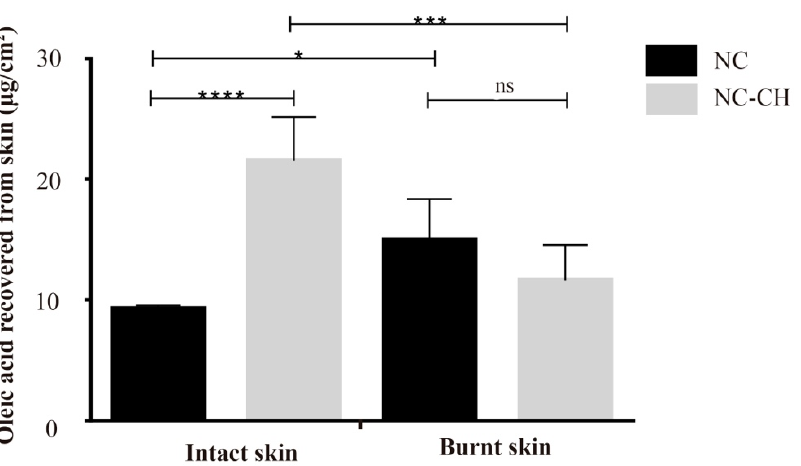
Figure 8. Penetration of oleic acid in burnt and intact skin samples treated 24 h with NC or NC-CH. ns non significant; * p < 0.05; *** p < 0.001, **** p < 0.0001.